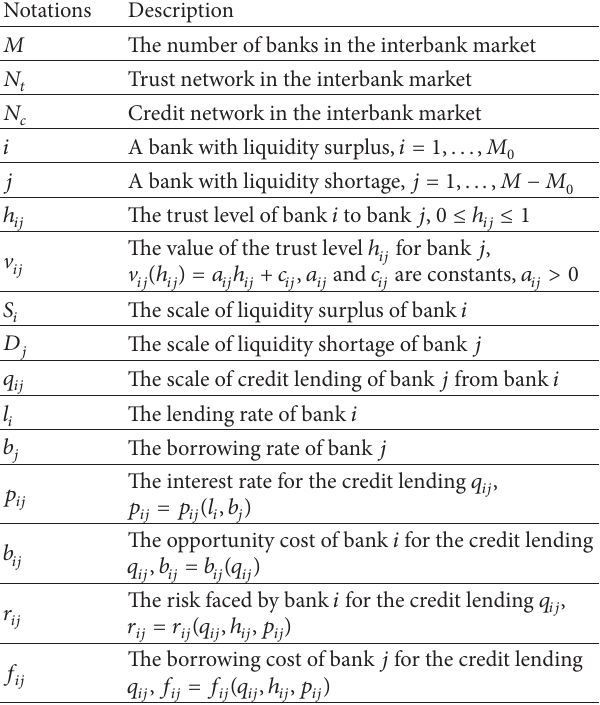
Table 1: Notations for the equilibrium